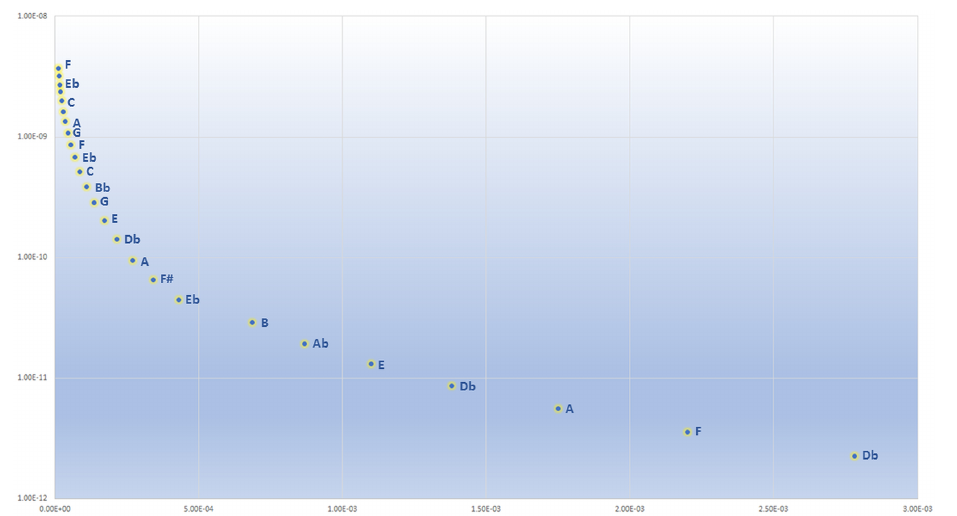
Figure 3. Sonified transient of a TEM sounding collected over the Selinunte temple, Sicily. The y axis shows the normalized voltage response of the Earth (V/Am 4 ), and the x axis shows the actual acquisition time of the geophysical instrument (in